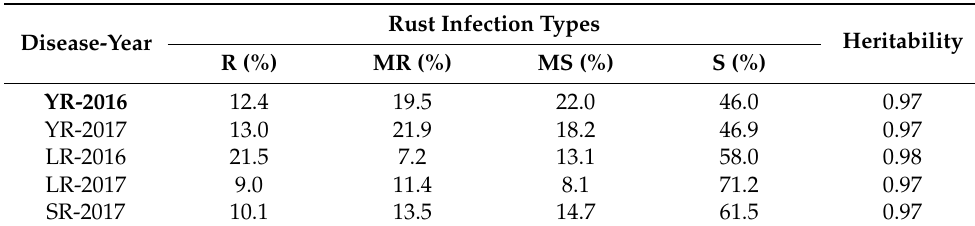
Table 1. Phenotypic percentage distribution for yellow (YR), leaf (LR), and stem (SR) rust, in 2016 and 2017, under field conditions.